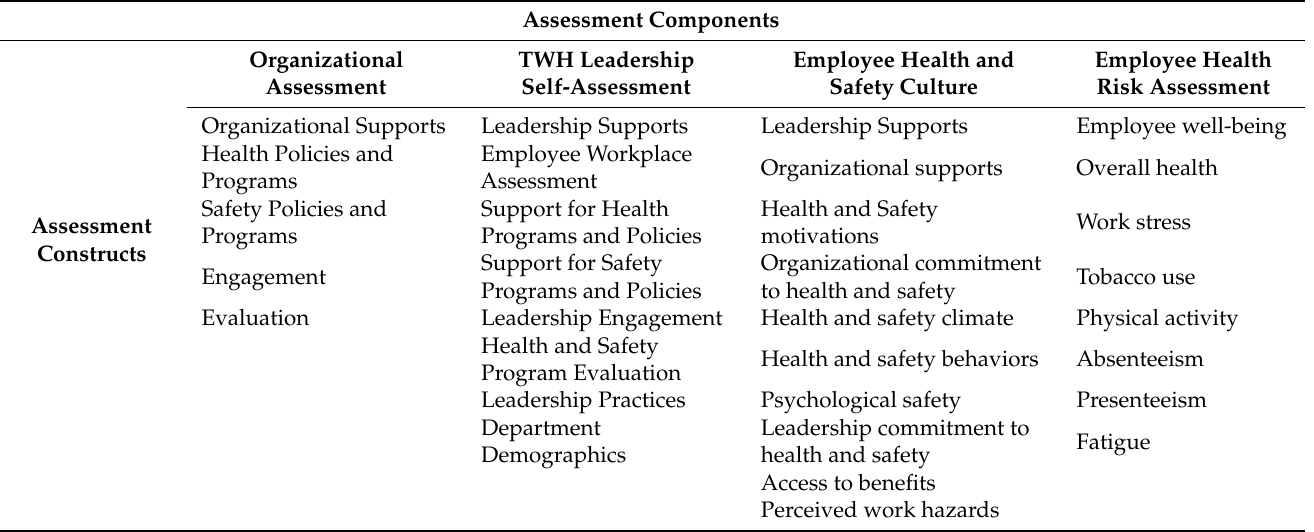
Table 1. TWH Assessment components and their